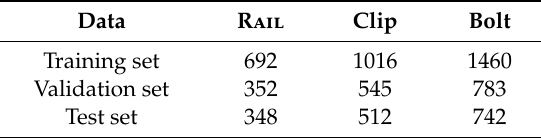
Figure 6. Railway track images from different angles: ( a ) Left side; ( b ) Right side; ( c ) Middle way. Table 1. Labeling